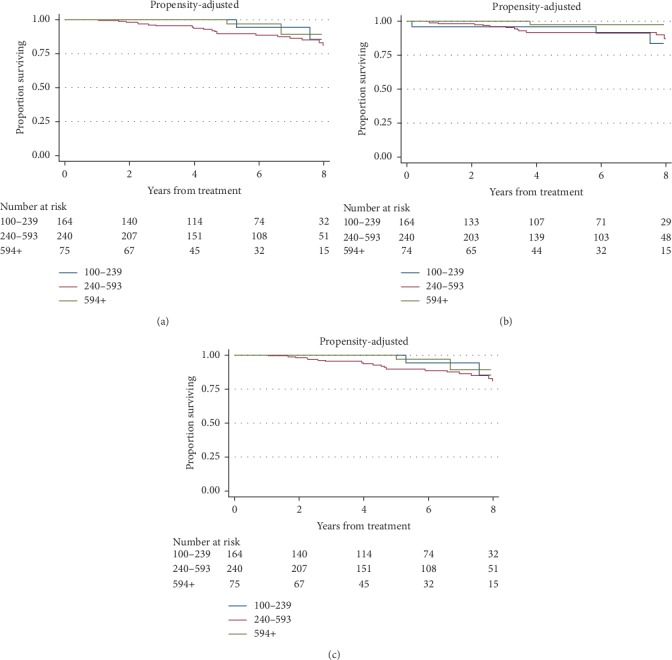
Propensity-adjusted Kaplan–Meier curves for progression fee (a), metastasis-free (b), and overall survival (c). The numbers at risk for each cohort represent the propensity-weighted population size. The actual population size for the 100–239, 240–593, and 594 +  cohorts is actually 39, 176, and 43 persons at baseline.